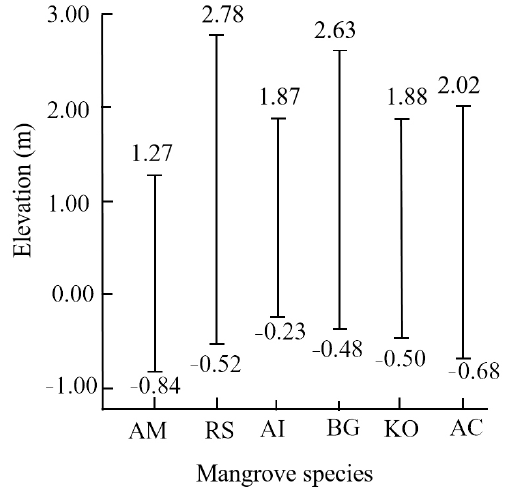
Figure 11. Mangrove elevation thresholds for A. marina (AM), A. corniculatum (AC), K. obovata (KO),